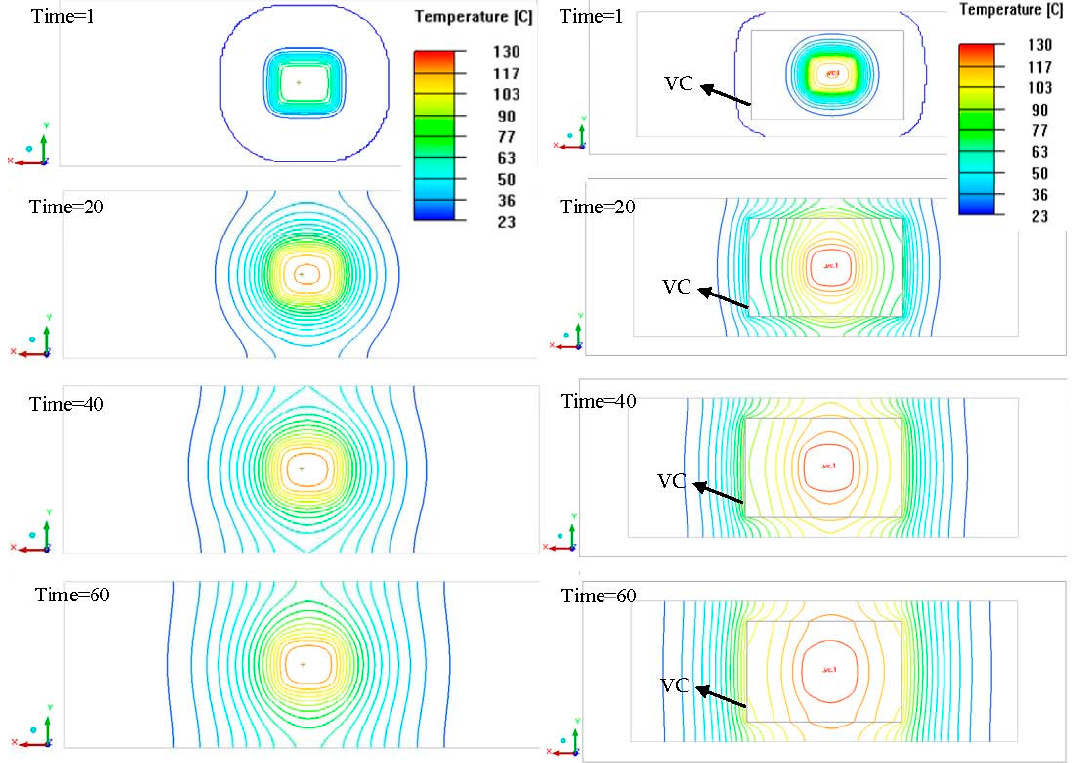
Figure 6. CFD simulation results. Two distinct mold designs, including one gate mold and two opposite gates mold in the present experiments, applied VCRHCS in tensile testing pieces, as shown in Figure 8. The tensile test samples were one and two gates, as shown in Figure 8a. The parts of the injection molding experimentations were tensile inspecting pieces. They assessed the successfulness of the heating and cooling system accompanied by a vapor chamber with no VC. The welding line was in the central position, and the tensile sectional area was smooth, as shown in Figure 8b,c. However, the cut sectional area was sharp for one gate tensile testing piece because there was no welding line in the central place. as shown in Figure 8d. Figure 9 exhibited testing pieces SEM images of welding line and the relationships of the temperatures with the heating time with/without VC. If there were no influence of VC, these welding lines are clearly displayed under the SEM photographs in Figure 9a. One gate piece had no welding line in the central position, as shown in Figure 9d. Raise the heating temperature, less obvious the welding line for using the VCRHCS. Figure 9b had a slight welding line at a heating temperature of 75 ◦ C. Figure 9c had almost no welding line at a heating temperature of 110 ◦ C. The dimensions of these tensile testing pieces were 215.9 × 12.7 × 25.4 mm 3 with a thickness of 3.175 mm. Table 1 shows the tensile intensity of the testing pieces in the distinct status of one gate and two opposite gates with and without VC and a 0.5% error. The tensile intensity theorizes the highest value for the one gate system due to no welding line in the central place from Figure 9d. There were no defects of welding lines in the tensile testing pieces from the no VC one gate system. The two gates with no VC heating apparatus showed obvious welding lines. Its tensile intensity dropped by 11.1%, more than the piece with one gate from Table 1 and Figure 9. The